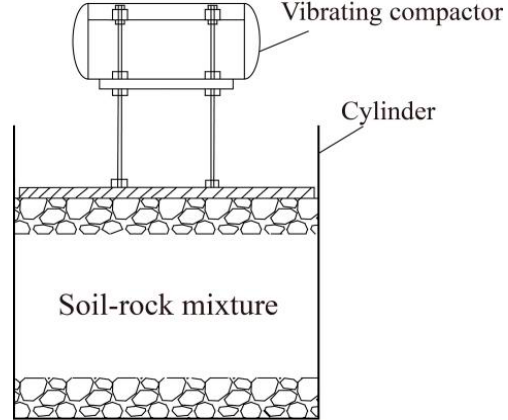
Figure 2. Diagram of the vibrating compaction on soil-rock mixtures.